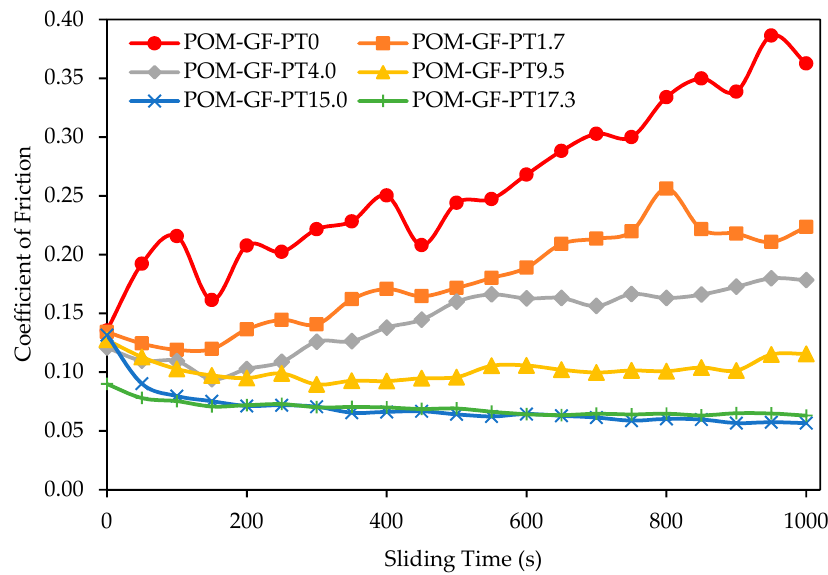
Figure 2. Characteristics of frictional coefficient as a function of sliding time for various POM/GF/PTFE composites.